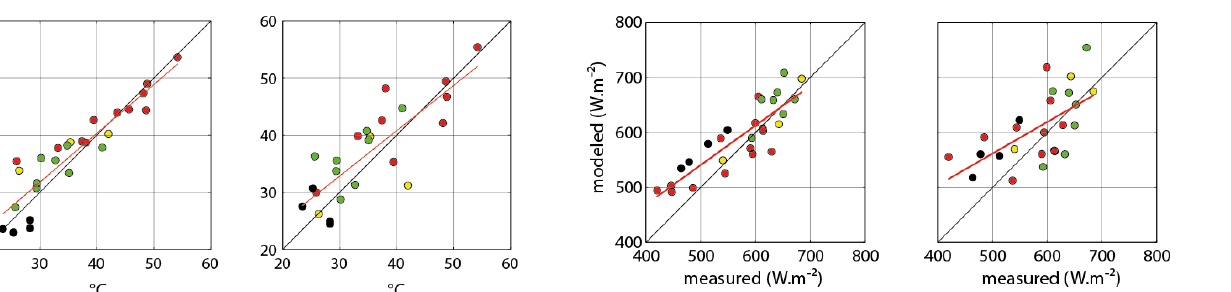
Fig. 4. ASTER (left panel) and ICARE (right panel) versus in situ radiometric surface temperature at each station at ASTER overpass dates. Color code: red: LAI < 0.4; yellow: 0.4 ≤ LAI < 0.8; green: 0.8 ≤ LAI < 1.2; navy-blue: 1.2 ≤ LAI < 2.0; black: LAI ≥ 2.0.